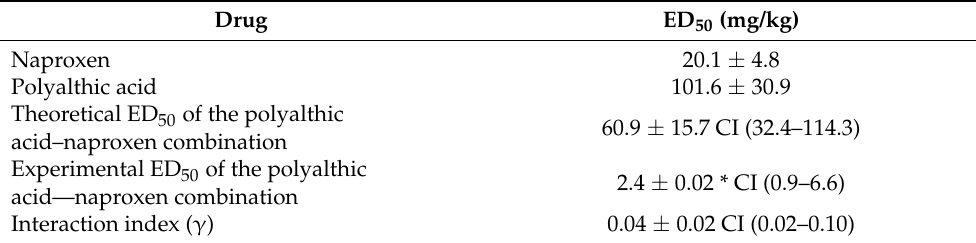
Table 2. The experimental ED 50 of naproxen and polyalthic acid, along with the theoretical and experimental ED 50 of the combination